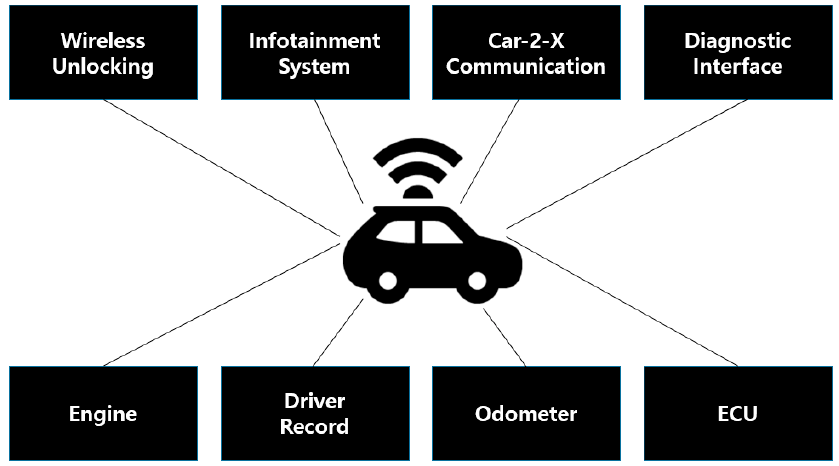
Figure 2. Vulnerability of Automobile Security (Source: Artificial News 2021).